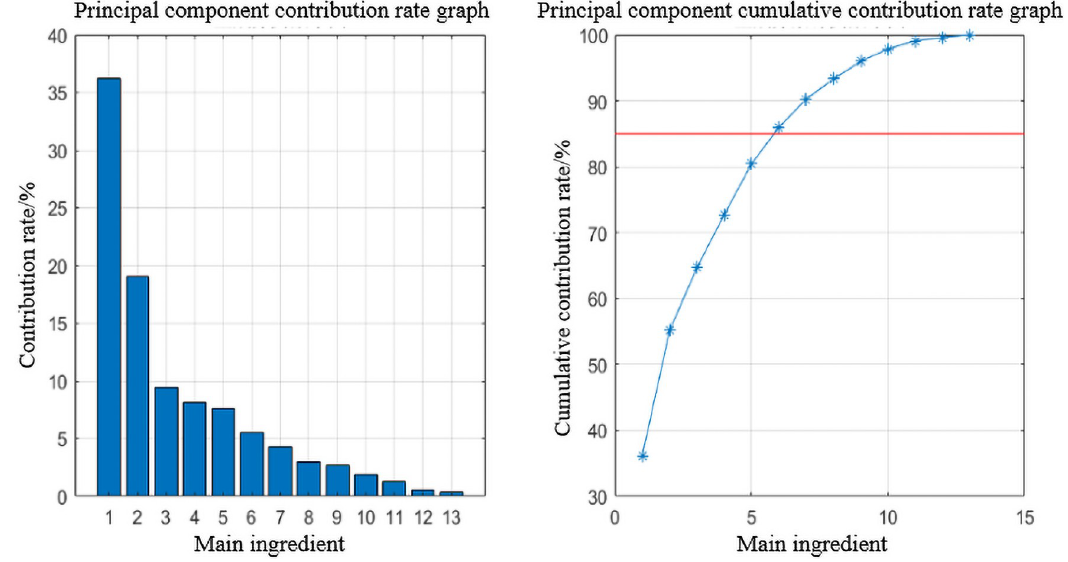
Fig 3. Principal component contribution rate and cumulative contribution